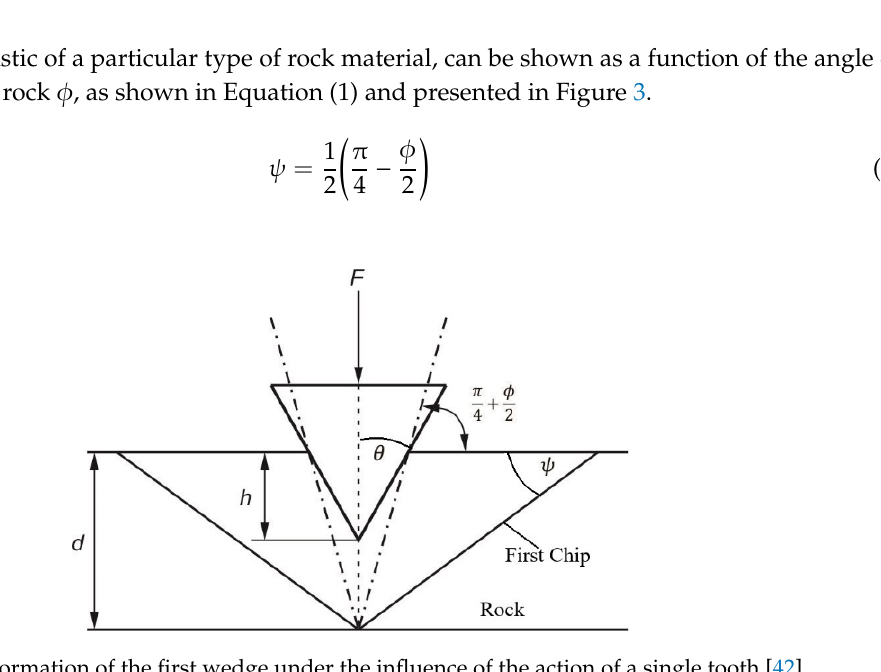
Figure 2. The model of penetration of one tooth into the rock [40 ].